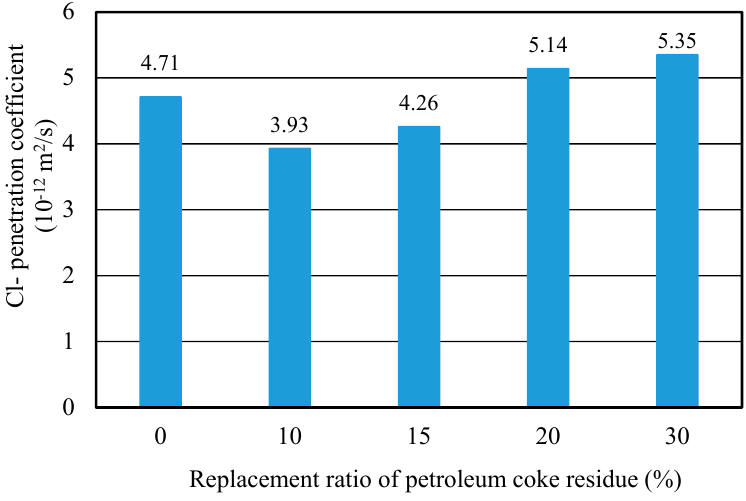
Figure 13. Cl − penetration coefficient of coke residue concrete with different replacement ratios.